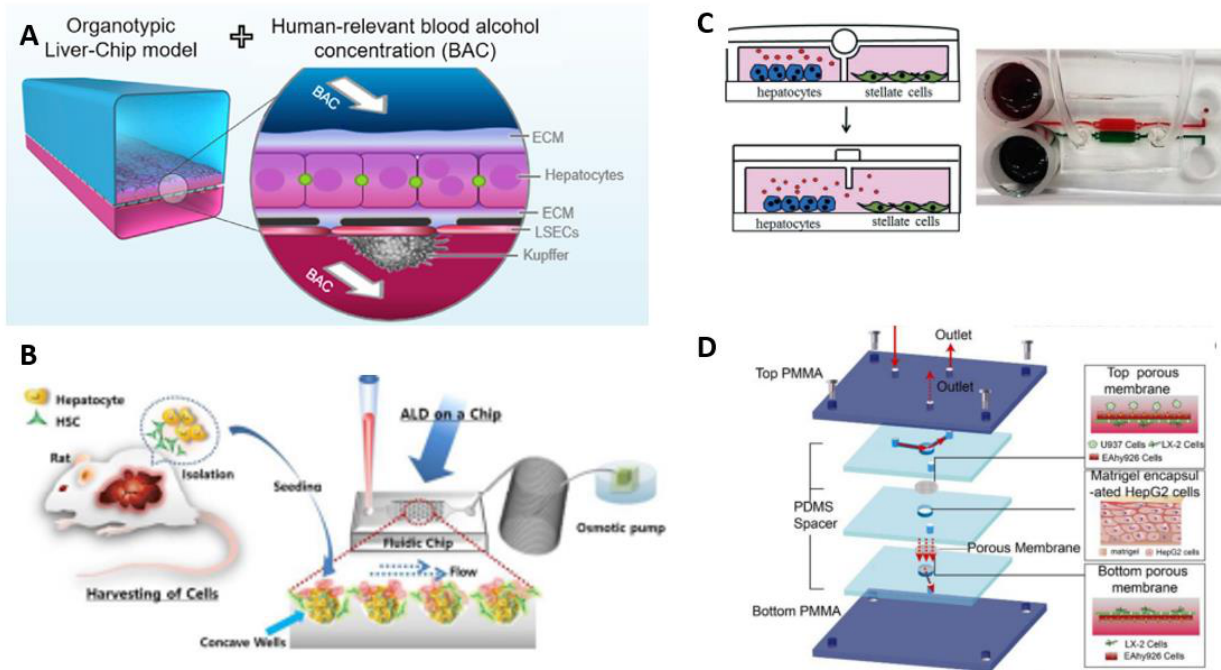
Figure 3. Modeling Alcoholic Liver Disease using microfluidic devices. ( A ) ALD Liver-Chip model with approach of exposing to alcohol [67] (reproduced with permission from Nawroth et al., 2020 Copyright: Cell Reports 36, 109393, July 20, 2021). ( B ) ALD model prepared by culturing primary hepatocytes with stellate cells in PDMS based Liver-on-Chip [68] (reproduced with permission from Lee et al., 2016). ( C ) Liver injury-on-a-chip representing non-mixing channels for co-culture growth [69], adapted from Zhou et al., 2015. ( D ) Liver-chip-based ALD design based on PMMA device with PDMS spaces and PC membrane to maintain cell lines [70] (reproduced with permissions from Deng et al., 2019).